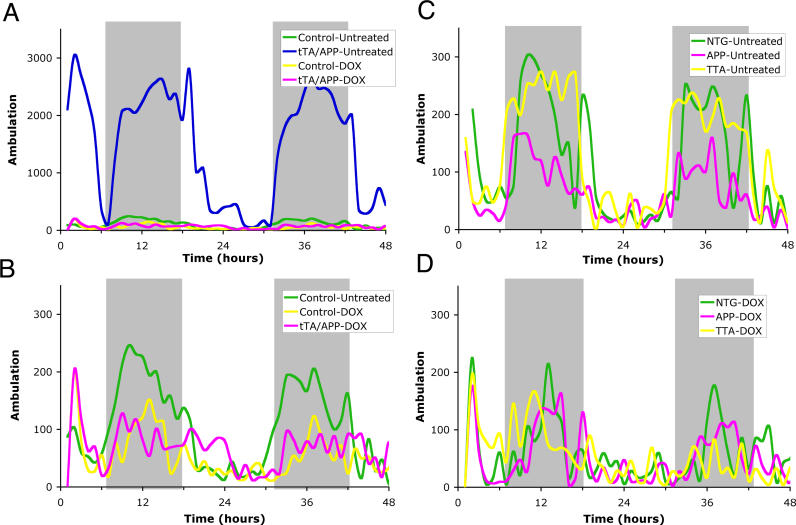
Transgene Suppression Attenuates Hyperactivity in tTA/APP Mice(A) A 48-h measure of ambulation records extreme hyperactivity in untreated double transgenic mice compared to single transgenic and nontransgenic controls (line 107). This phenotype is completely eliminated by rearing the double transgenic mice on dox.(B) The same data shown in (A) are replotted to magnify data from untreated control and dox-treated groups.(C and D) Activity levels in the combined control groups of (A) and (B) are here separated by genotype. None of the single transgenic or nontransgenic control groups display the hyperactivity present in untreated tTA/APP animals. Again, note the y-axes have been enlarged for detail compared to (A).